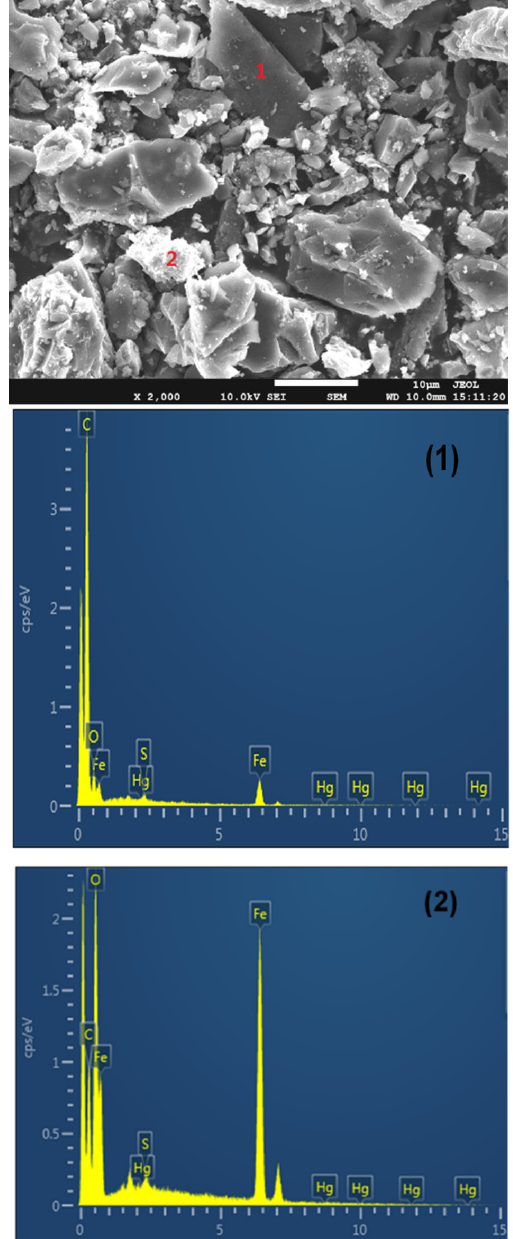
Figure 3. SEM-EDX analysis of Fe 2 O 3 after Hg 0 and H 2 S removal (( 1 ) position 1, ( 2 ) position 2). To confirm the catalytic oxidation activity of Fe 2 O 3 in Hg 0 removal, TPD experiments were conducted to identify the speciation of Hg adsorbed over Fe 2 O 3 /AC. Figure 4 shows the Hg release behaviors of the fresh (Fe10/AC) and spent Fe10/AC (Fe10/AC-Hg) cata- lysts upon heating to 600 ◦ C in Ar. It can be seen that the fresh Fe10/AC sample showed no Hg release during the TPD process. As for the spent Fe10/AC sample, however, it showed two obvious Hg release peaks at about 198 ◦ C and 296 ◦ C, which could be attributed to HgS (black) and HgS (red) [28–30]. This indicated that the form of Hg captured over Fe 2 O 3 /AC were mainly Hg 2+ compounds, confirming the oxidation of Hg 0 to Hg 2+ by Fe 2 O 3 and the reaction of Hg 2+ with H 2 S to form HgS. These were consistent with the results of Hg 0 oxidation and the reaction on Fe 2 O 3 -based catalysts